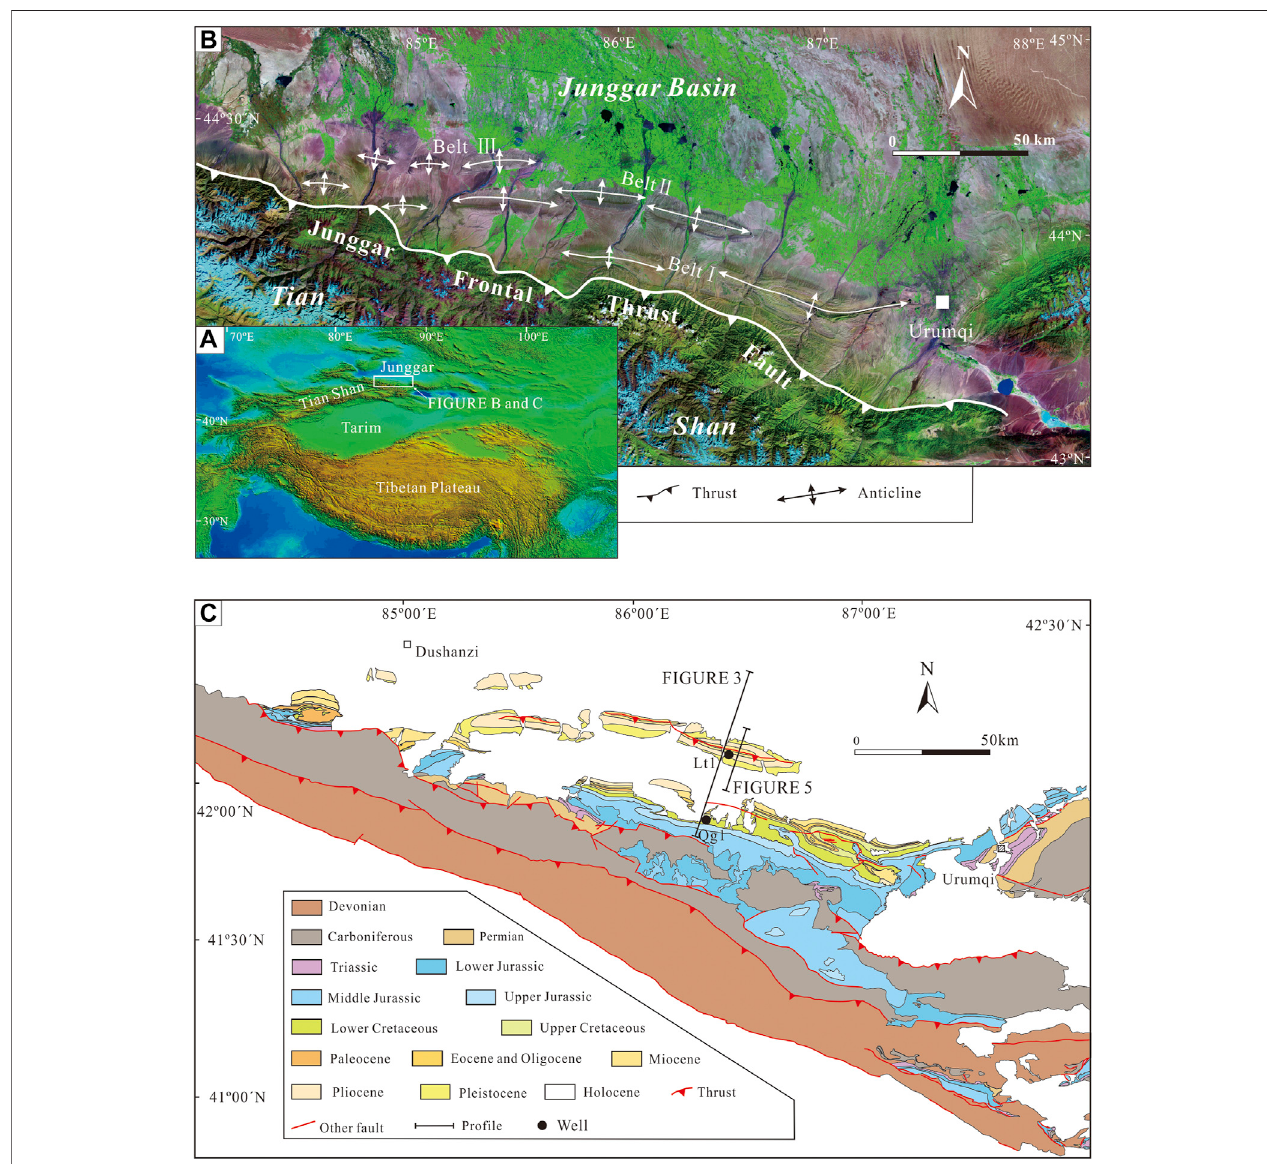
FIGURE 1 | Satellite image and geologicmap ofthe study area. (A) : Digital elevation map ofthe Tibetan Plateau and surrounding areawhere the white box shows the locationofthe study area. (B) : Enhancedthematicmapperimage shows thatthe TianShanand Junggar Basin areseparated bytheSouthern Junggar fold-and-thrustbelt. (C) : Geological map of the Southern Junggar fold-and-thrust belts (Bureau of Geological and Mineral Resources of the Xinjiang Uygur Autonomous Region, 1985).